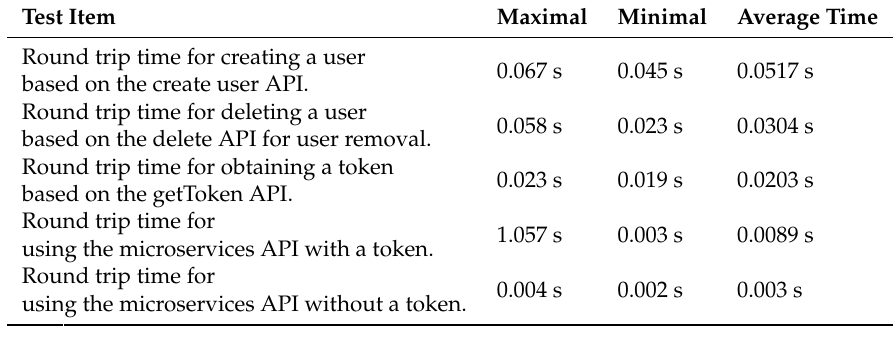
Table 3. Round trip time test results.